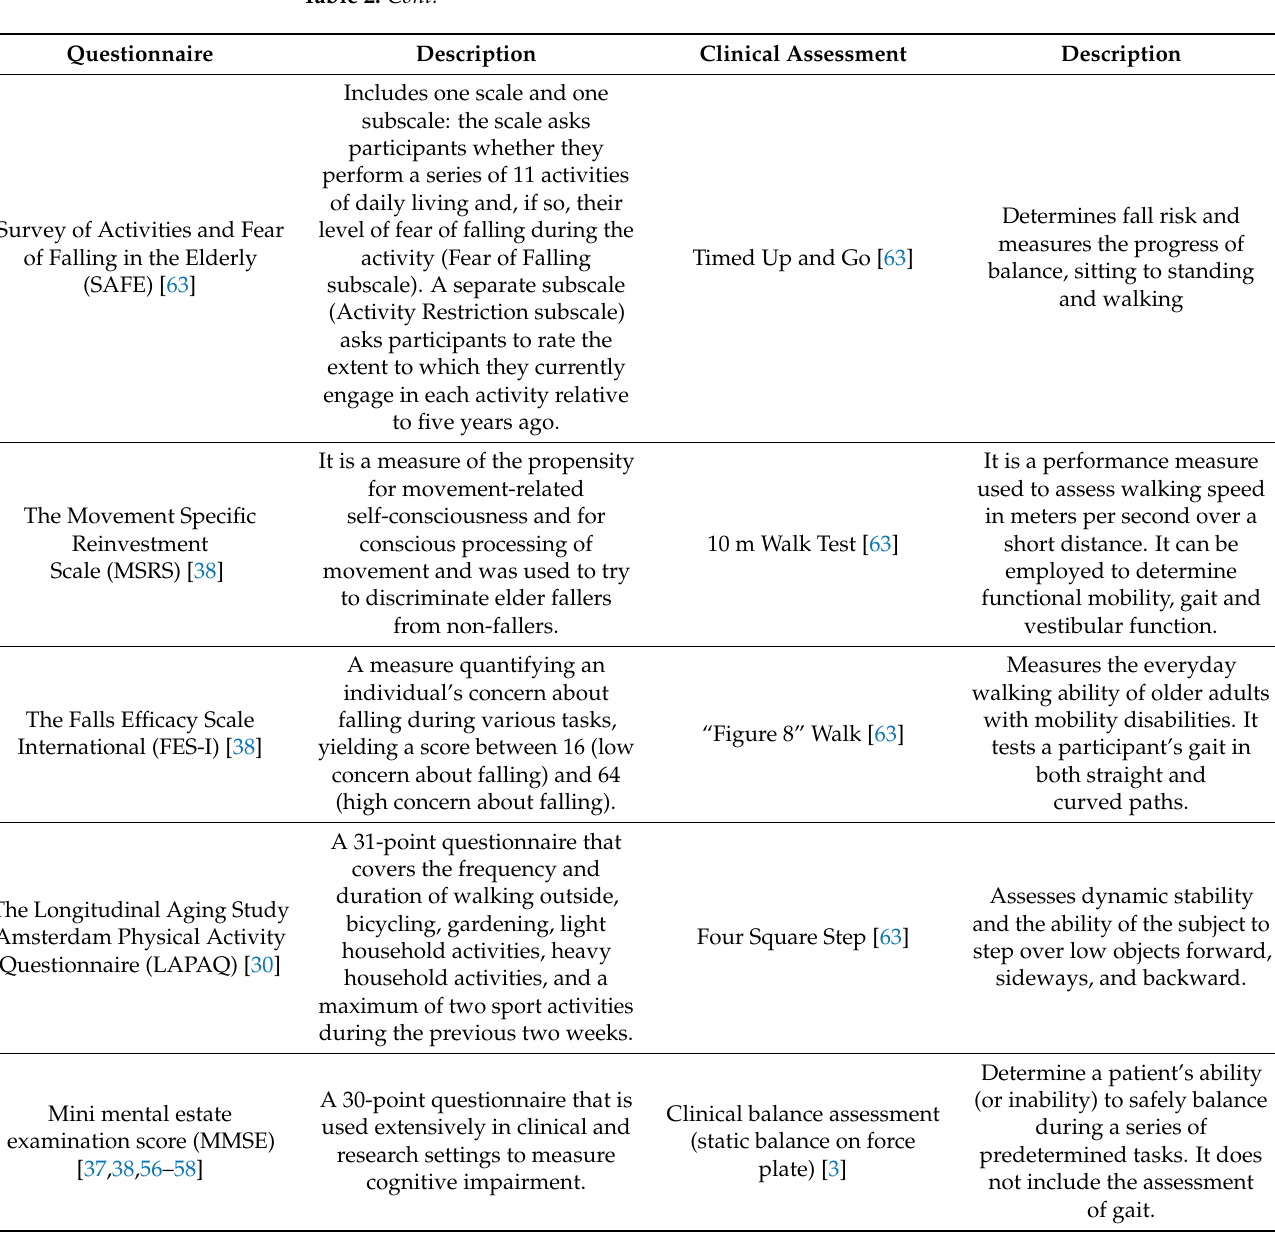
“Figure 8” Walk [63]